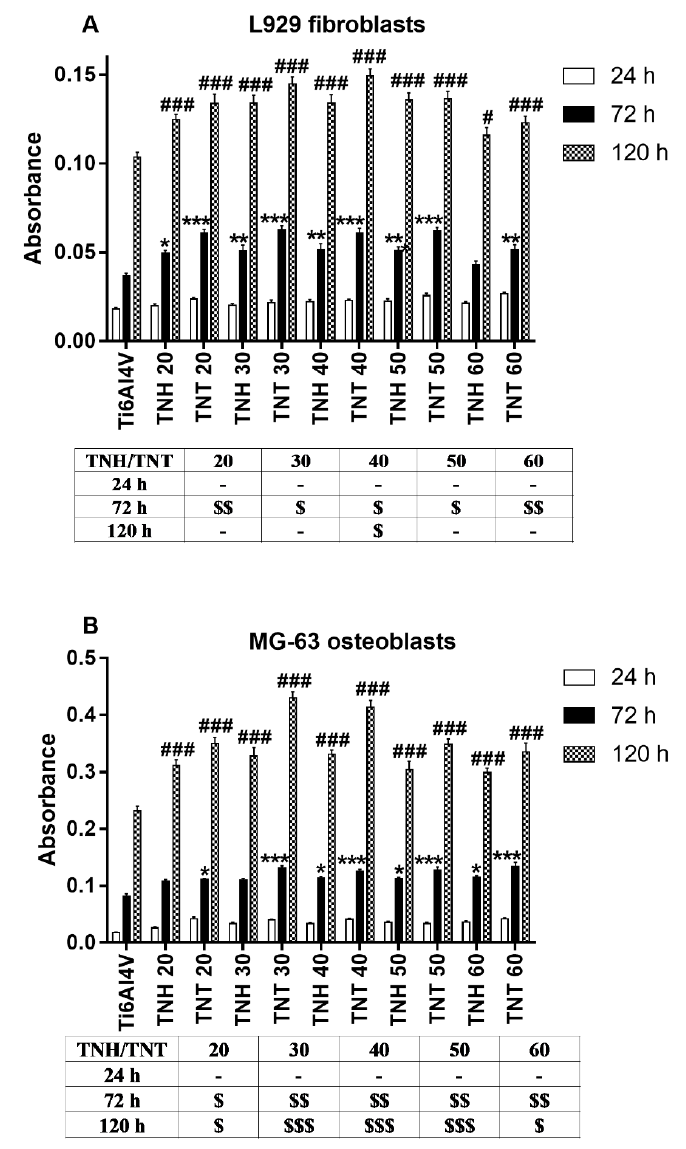
Figure 7. L929 murine fibroblasts ( A ) and human osteoblasts MG-63 ( B ) proliferation (after 24-, 72- and 120 h) on the surface of Ti6Al4V/TNH20-TNH60 and Ti6Al4V/TNT20-TNT60 samples, detected by MTT assay. The absorbance values are expressed as means ± SEM of five independent experiments. Asterisk and hash mark indicate significant differences between the cells incubated with the alloy references samples (Ti6Al4V) compared to the TNH and TNT specimens after 72 h (* p < 0.05, ** p < 0.01, *** p < 0.001) or 120 h ( # p < 0.05, ## p < 0.01, ### p < 0.001) of incubation time, respectively. Tables below the graphs A and B present the statistical differences in the proliferation of the cells, between TNH and TNT coatings produced by the electrochemical anodization of the Ti6Al4V foil at the same selected potential ( $ p < 0.05, $$ p < 0.01, $$$ p < 0.001). Analysis of these data revealed also that there were no differences in the cells proliferation after 24 h between the all tested samples and titanium alloy references sample (Ti6Al4V). In contrast,